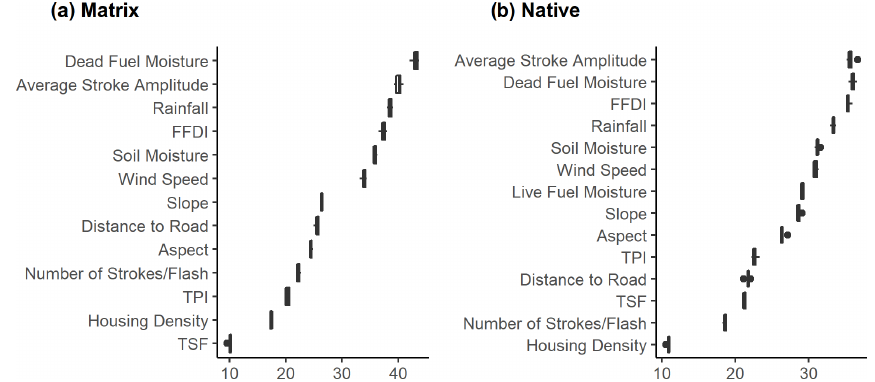
Figure 6. Variable importance of predictors for the probability of a lightning flash causing an ignition in (a) matrix and (b) native forest. Average and standard deviations of the included node purity calculated by averaging the residual sum of squares over all trees in a random forest model for each model used in the 10-fold